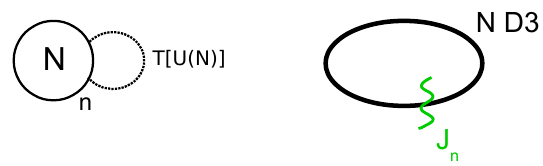
Figure 2 . Quiver description of the J n theories and their brane realization. The subscript n is the Chern-Simons level of the U( N )